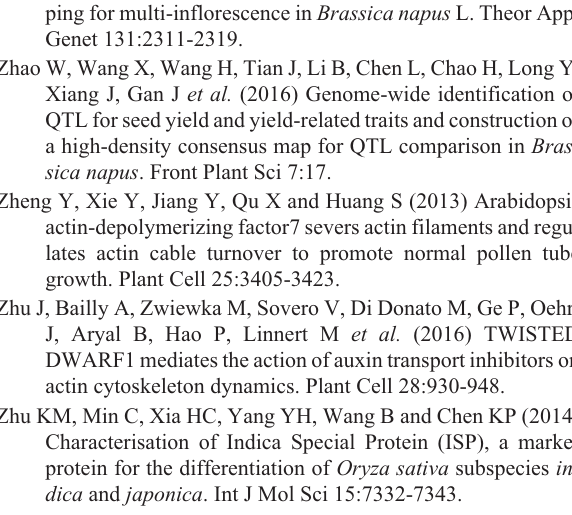
Figure S1 - The relative expression levels of selected genes which changed significantly in the 2-DE result. Table S1 - Primers used for